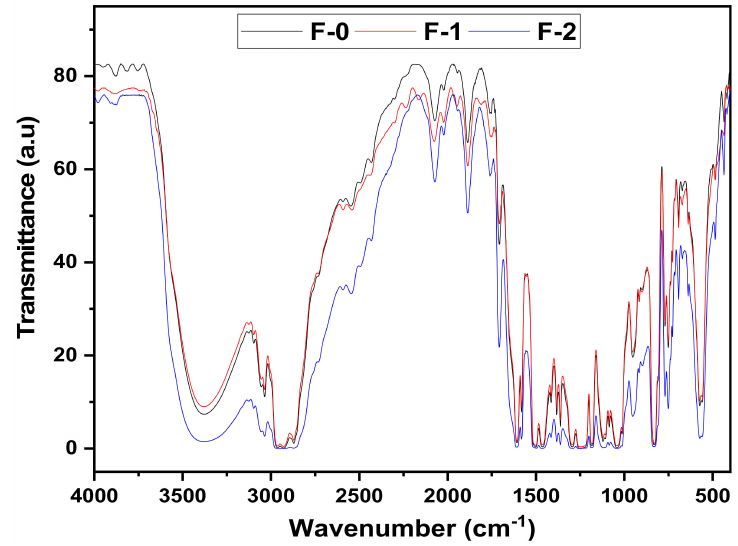
Figure 2. FTIR spectrum of formulation with PA-3282